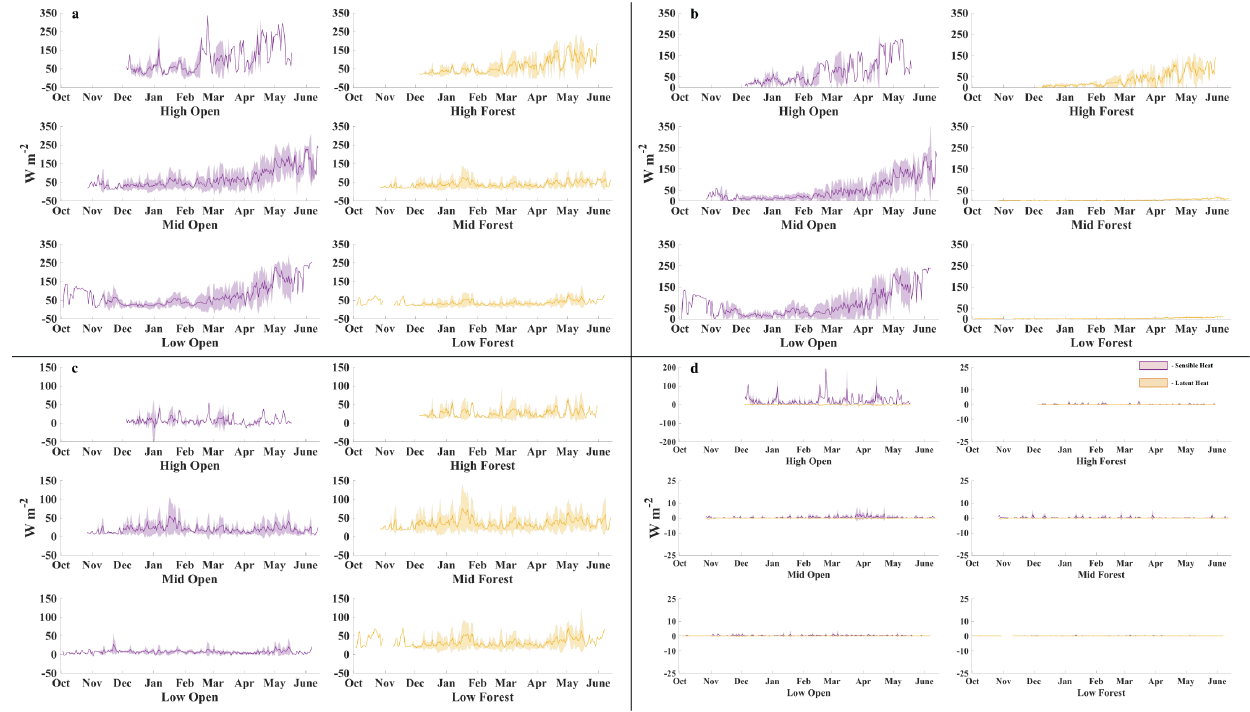
Figure 4. Calculated daily mean energy balance in Wm − 2 (solid line) and the range of values (shaded area) for (a) net energy at the snow surface; (b) net solar radiation; (c) net longwave radiation; and (d) net turbulent energy at the snow surface for each site within the ForEST network, WY 2012–WY